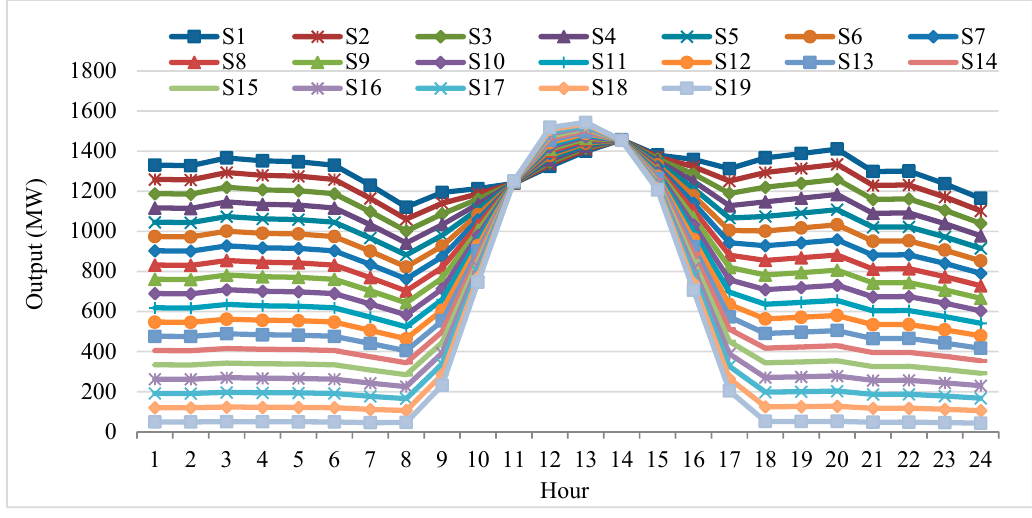
Figure 7. Output profile of the selected VGR for the peak-load day.